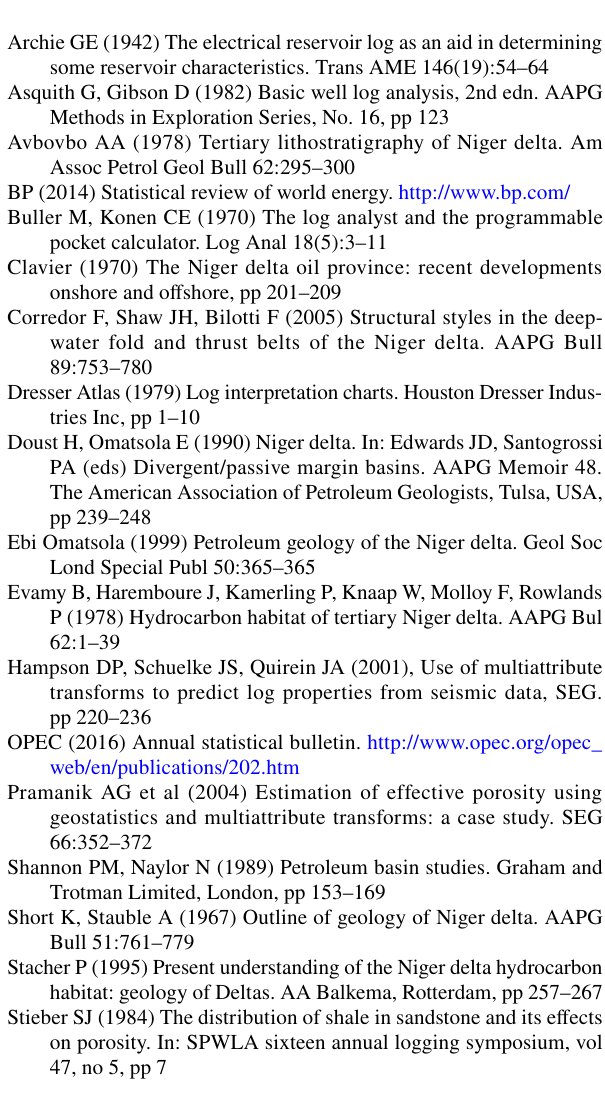
Fig. 19 Net-to-gross time slice at top of reservoir